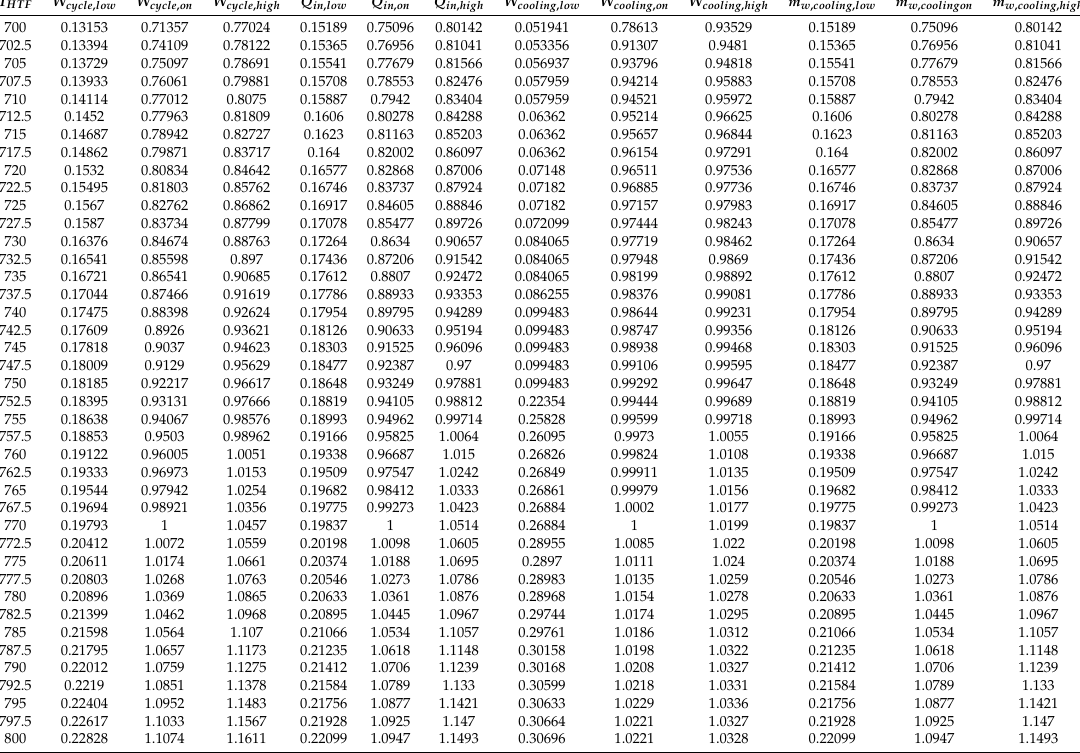
Table A1. Performance as a function of HTF temperature (MOD1) table for Allam cycle. “Low”, “On” and “High” respectively refer to the three normalised mass flow employed: 0.2, 1 and 1.05. T